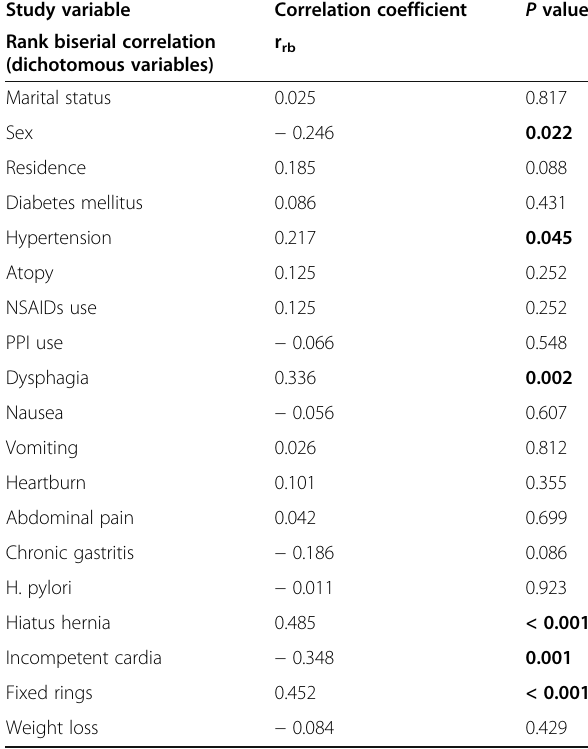
Table 1 Descriptive statistics of demographic, clinical, endoscopic and histopathological parameters of the studied cases ( N = 86)